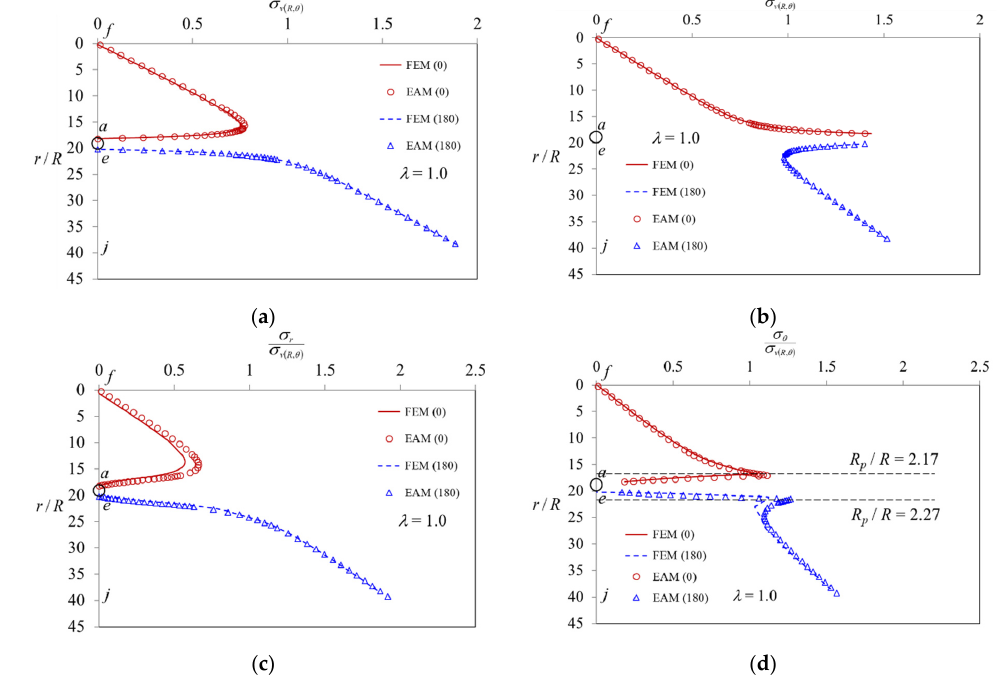
Figure 18. Ground reaction around the tunnel obtained by EAM and FEM in Case I ( θ = 0°) and Case III ( θ = 180°) with λ = 1.0 and K o = 0.8, and the distribution of ( a ) radial stress in the elastic media, ( b ) tangential stress in the elastic media, ( c ) radial stress in the elastoplastic media, and ( d ) tangential stress in the elastoplastic media.